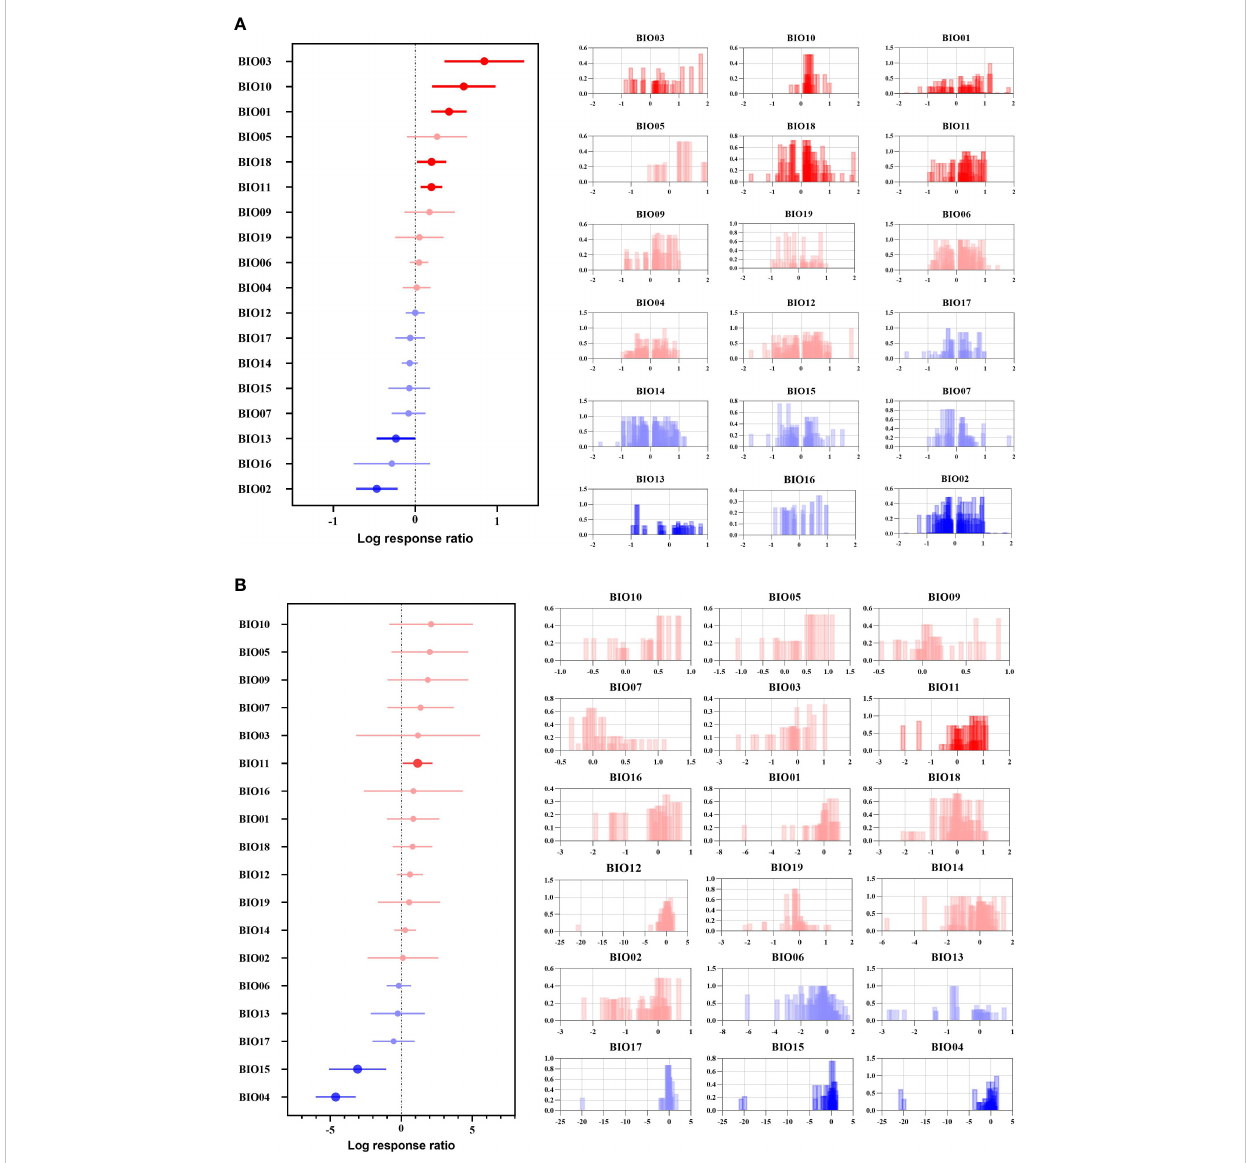
FIGURE 2 Effect sizes of different climate factors. (A) indicates the overall suitable area, and (B) indicates the highly suitable area. The left side represents the effect of 18 climate factors on the future overall/highly suitable area (main effects) for woody plants, and error lines indicate 95% con fi dence intervals. The right panel is a histogram of the impact of the contribution of each climate factor to the effect values. Positive effect (red color), signi fi cant positive effect (bright red color), negative effect (blue color), and signi fi cant negative effect (bright blue